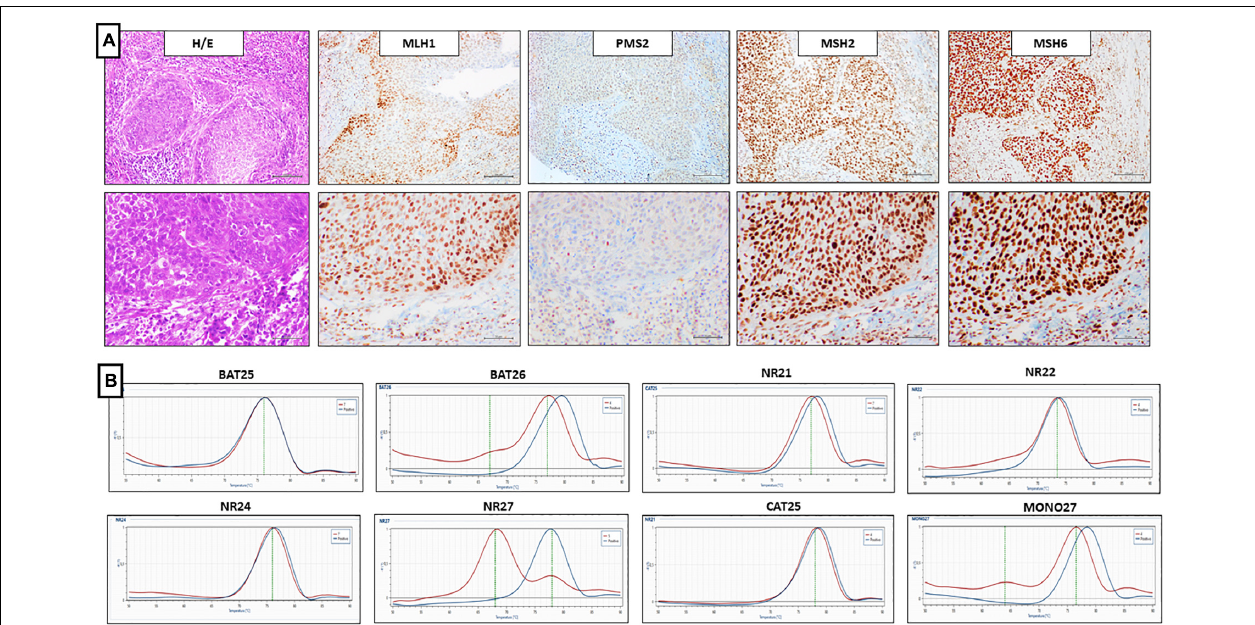
FIGURE 4 | Representative results of penile SCC case showing lo-paMMR IHC and MSI-H by PCR. (A) Upper line (from left to right) MMR-IHC results: Hematoxilin and Eosin penile SCC, intact exspression of MLH1, MSH2 and MSH6, loss-patchy expression of PMS2 (20x magnification, scale bar = 100 µ m); lower line (from left to right) MMR-IHC results: Hematoxilin and Eosin penile SCC, intact exspression of MLH1, MSH2 and MSH6, loss-patchy expression of PMS2 (40x magnification, scale bar = 200 µ m). (B) MSI-PCR results: stability of BAT25, NR21, NR22, NR24 and CAT25, instability of BAT26, NR27, and MONO27 (red lines indicate samples while blue lines indicate MSS controls).